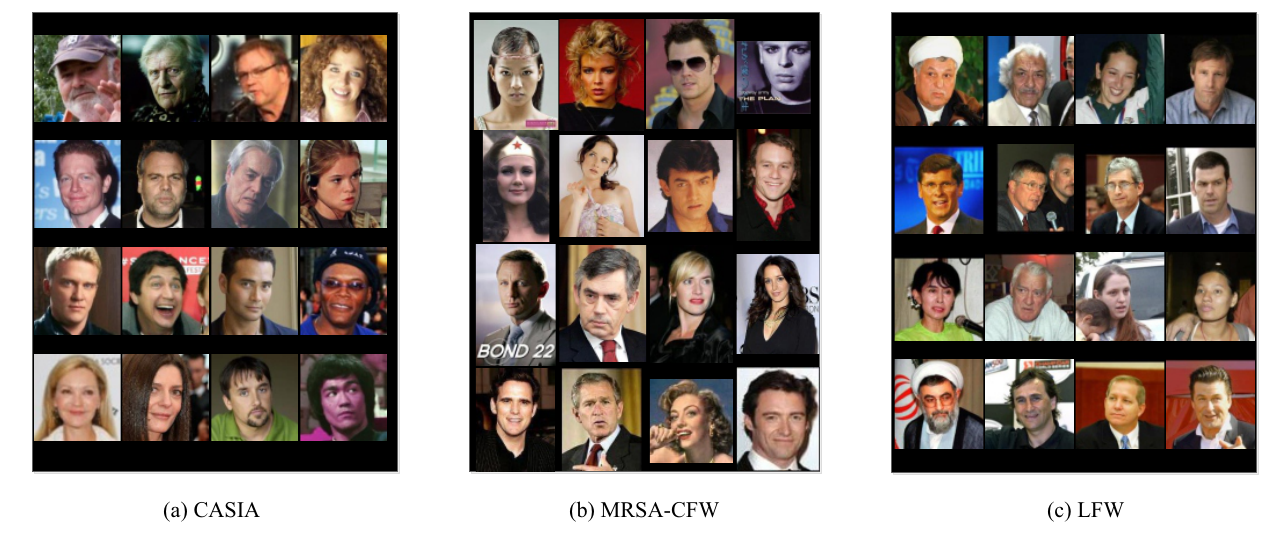
Fig. 5 Example of face images from the three face